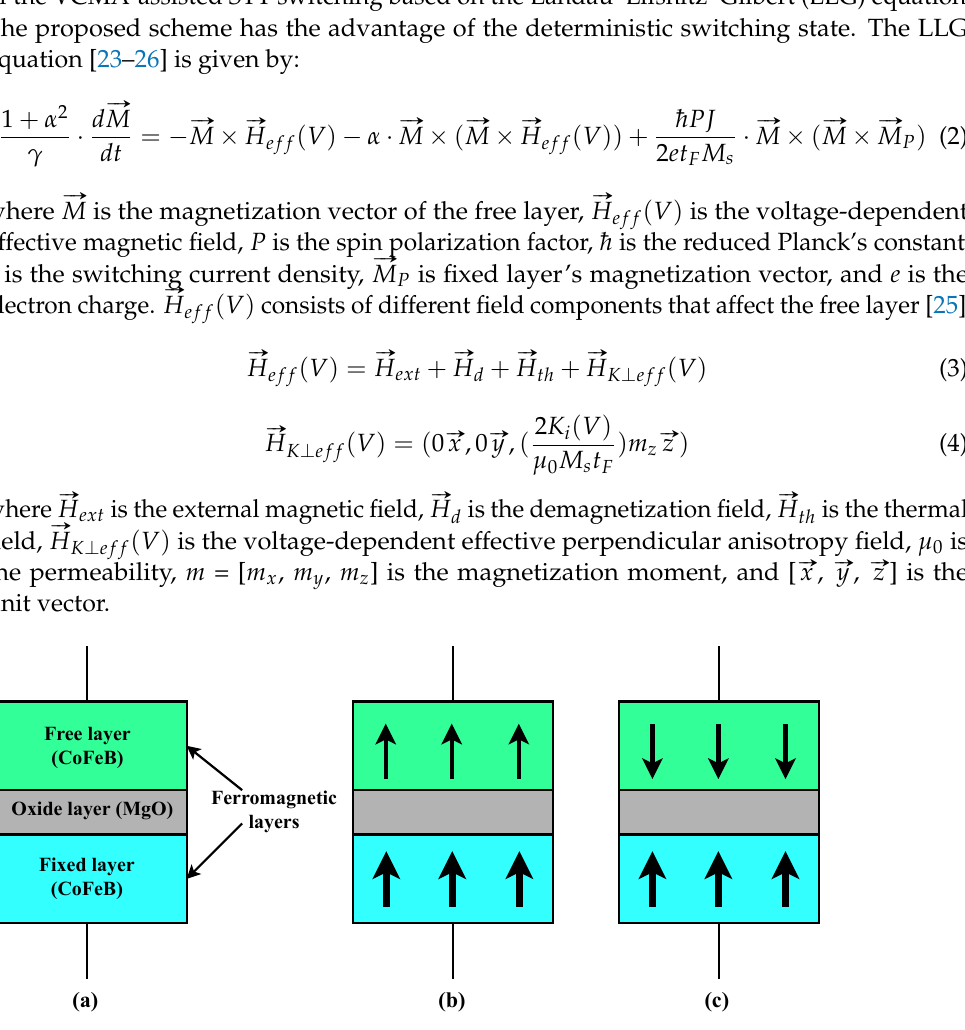
Figure 1. ( a ) Vertical structure of the MTJ. ( b ) MTJ’s parallel state/high logic value (1)/low resistance. ( c ) MTJ’s antiparallel state/low logic value (0)/high